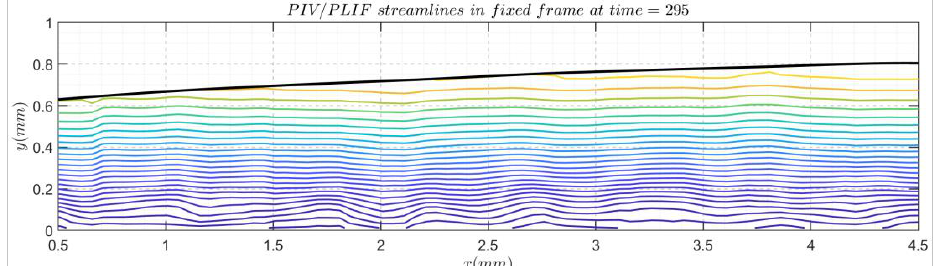
Figure 11. Comparison between the experimental instantaneous velocity profiles and corresponding model-reconstructed velocity profiles for the Re = 41.05, f = 5 Hz water film flow case.